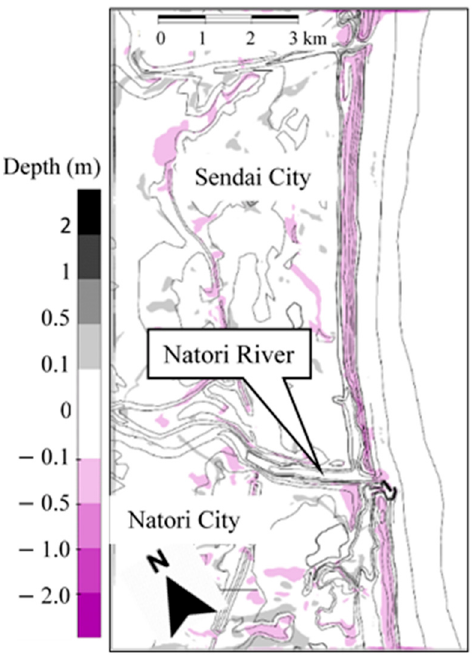
Figure 6. Topography change results (suspension load only), 48 min after calculation.